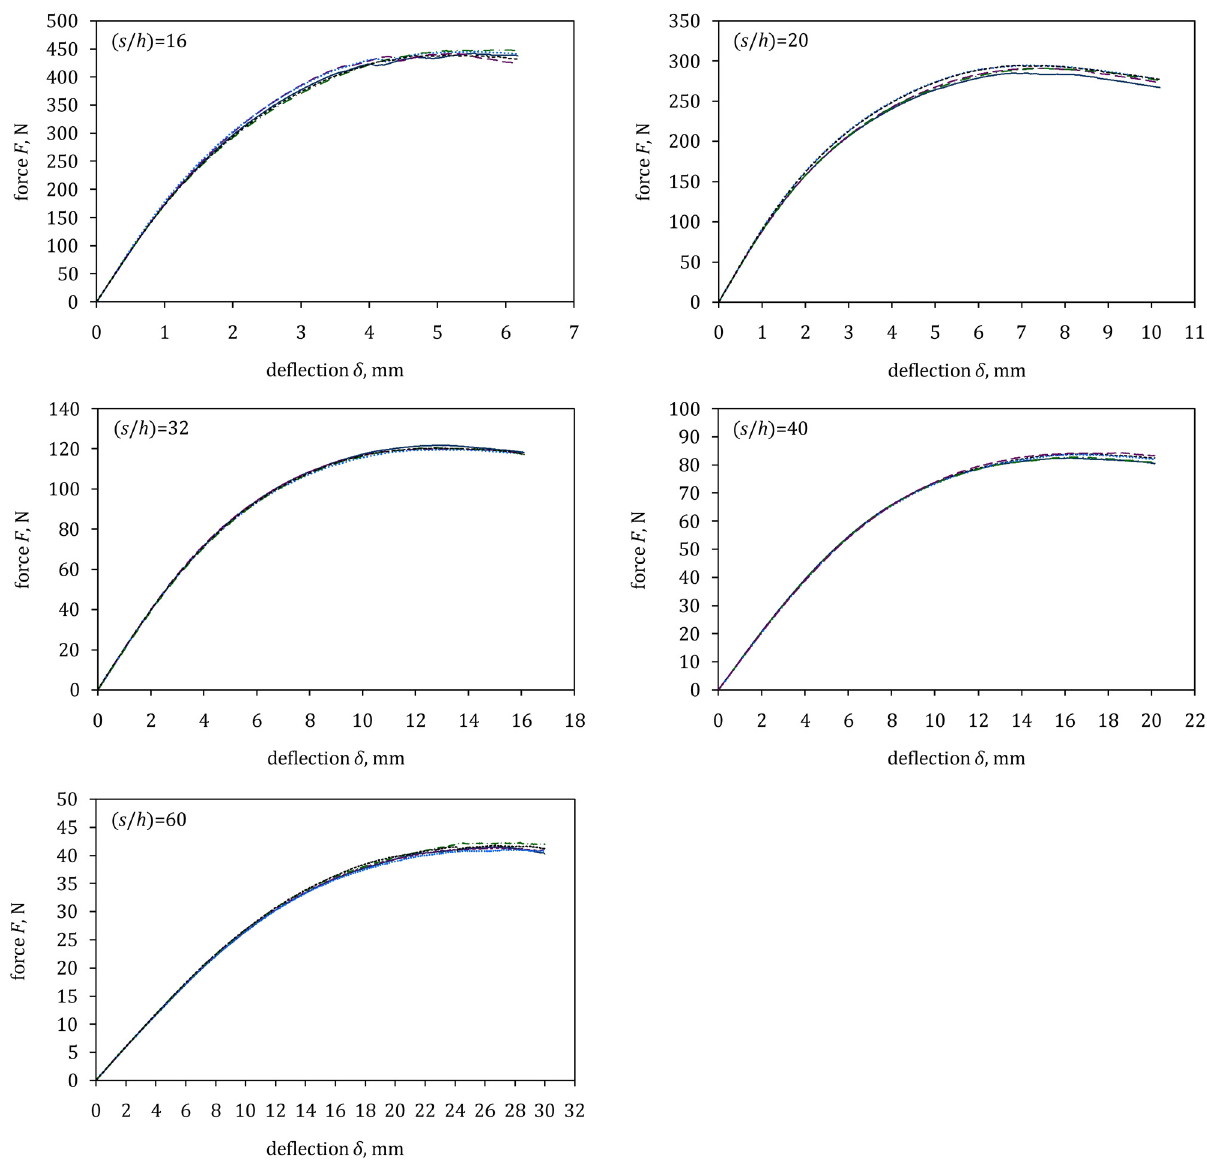
Figure 7: Flexural force – de fl ection responses of the 45° o ff - axis specimens for various values of ( s / h )